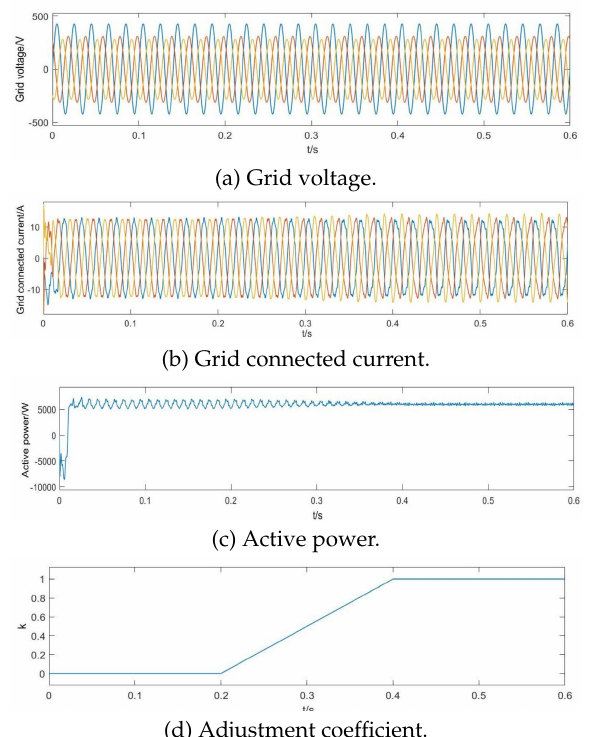
Fig. 11. Simulation results using the control scheme in this